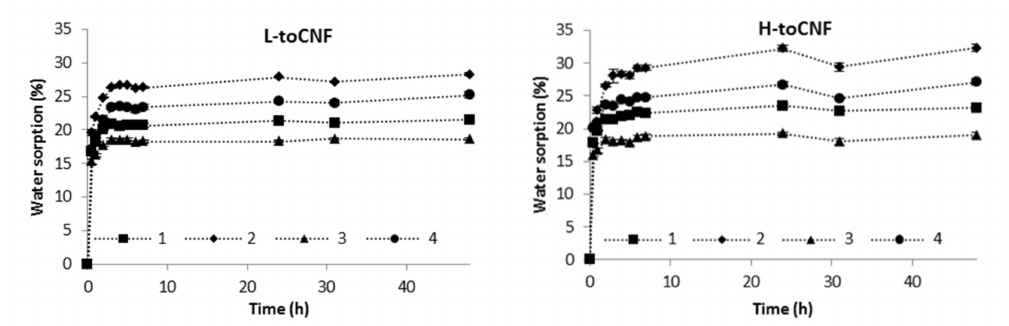
Figure 2. Water sorption as a function of time of conditioning at 25 ◦ C 90% relative humidity (RH) for L-toCNF (left) and H-toCNF (right). Table 3. Sorption equilibrium after 48 h and % of sorption after 30 min for low-charge content